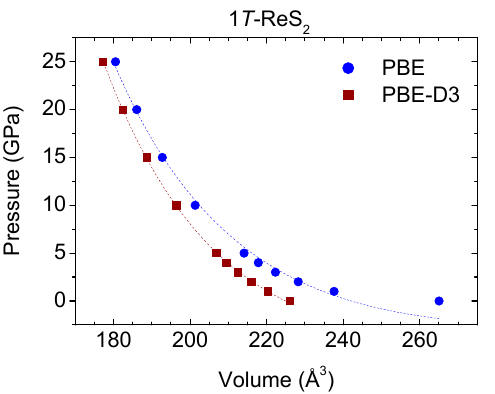
Figure 3. PBE-DFT calculations of the P - V equation of state of 1T-ReS 2 , with (squares) and without (solid dots) D3 van der Waals correction.